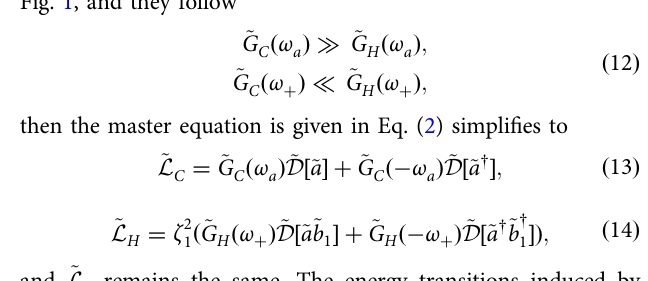
( A (cid:2) ) represents upward (downward) transition rate due here A þ c c to the optically fi ltered baths (Fig. 1), and given by